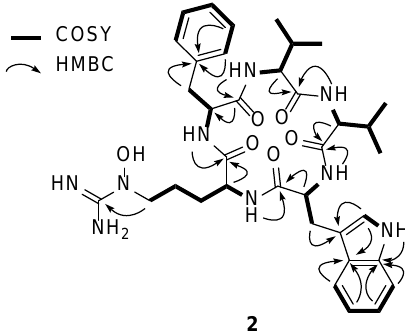
Figure 2. Key COSY and HMBC correlations of pentaminomycin D ( 2 ).